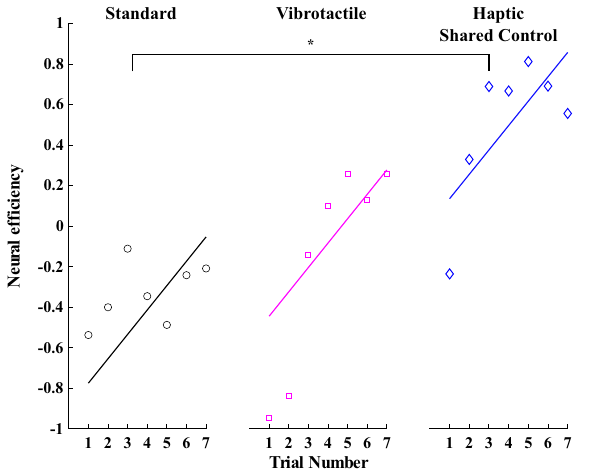
Figure 8. The neural efficiency for each trial, where the individual data points represent the average for each trial (for all participants in each group), and the solid lines indicate the model’s prediction. * indicates p < 0.05 , ** indicates p < 0.01 , and *** indicates p < 0.001 .